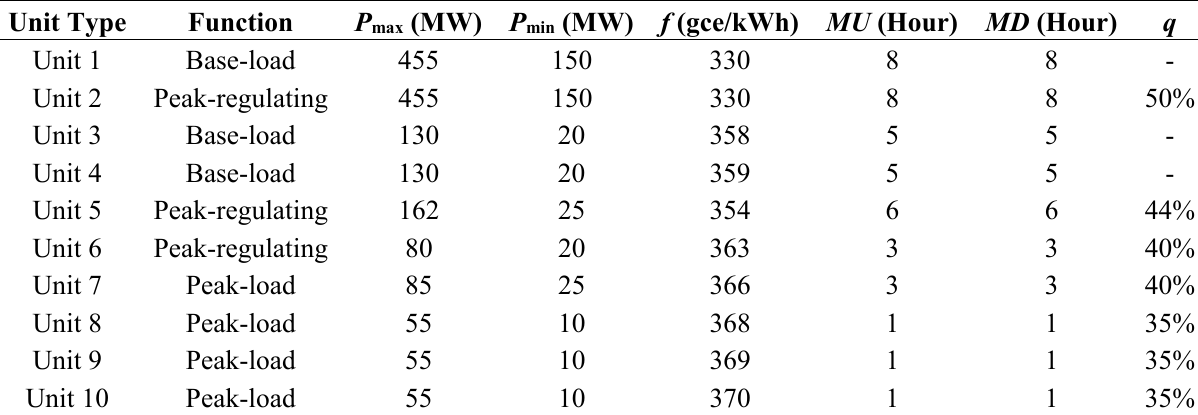
Table 3. The parameters of generation agent for providing